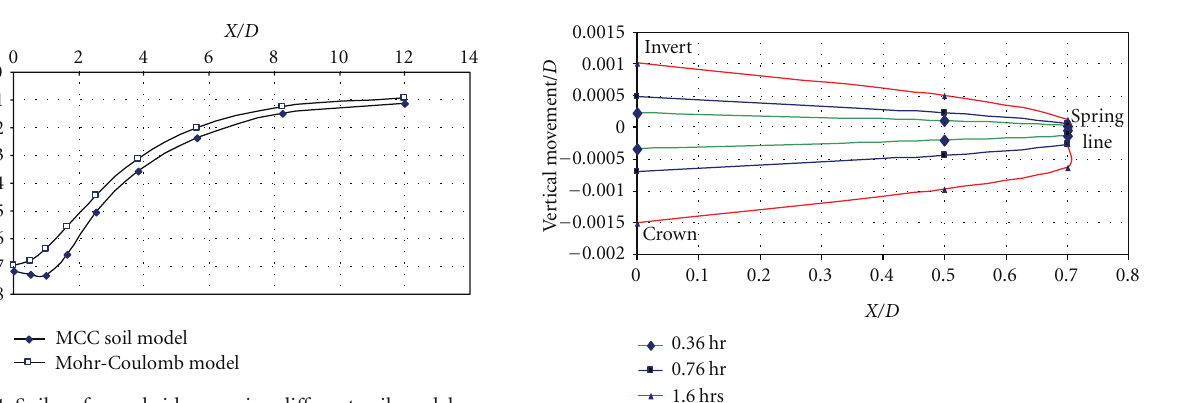
Figure 4: Soil surface subsidence using di ff erent soil models.